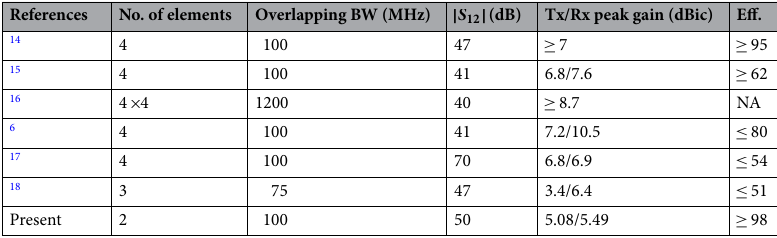
Table 1. Comparison with CP IBFD antennas in the